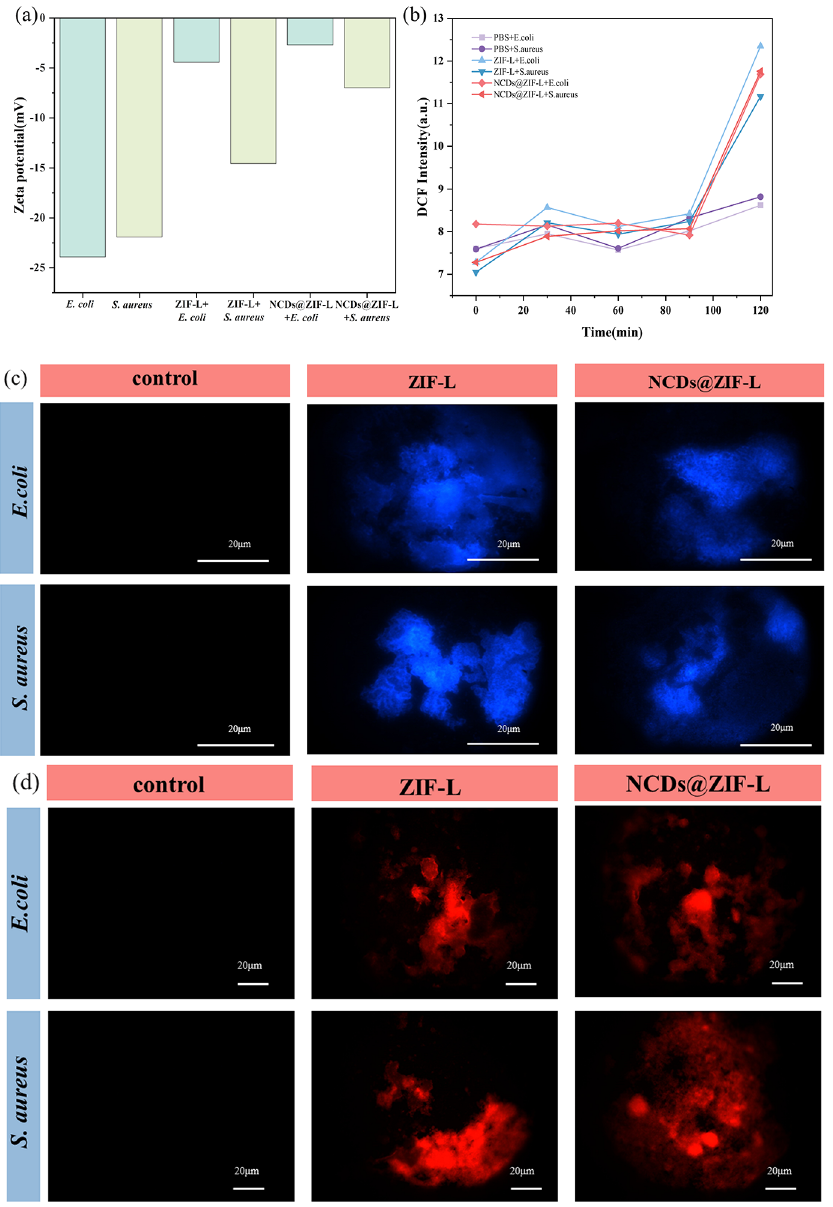
Figure 6. Antibacterial mechanism. ( a ) Zeta potential of E. coli and S. aureus after treated. ( b ) ROS production at different times of co-culture of bacteria and materials. Fluorescence images of bacteria stained with 33342 dye ( c ) and PI staining ( d ) after material